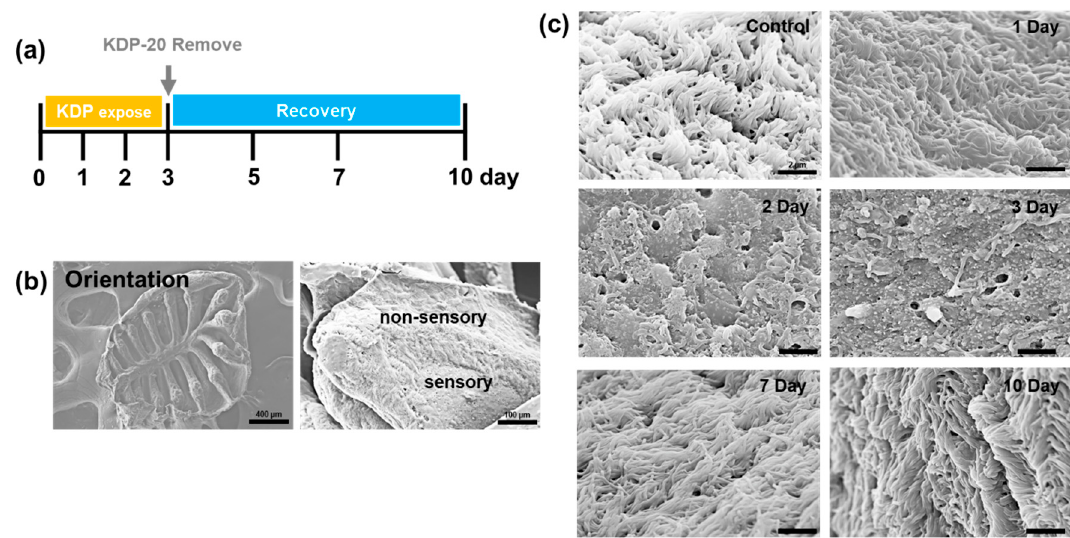
Figure 3. ( a ) Scheme of KDP20 exposure experiment. ( b ) Orientation of olfactory organs. Olfactory organ has rosette-like shape and contains non-sensory and sensory area. To analyze the damage of KDP20 exposure to olfactory sensory neurons (OSNs), we observed cilia and the epithelium of the sensory area. Scale bar = 100 µm. ( c ) Field emission scanning electron microscope (FE-SEM) images of cilia in the sensory area of control, damage group (1, 2, and 3 days), and recovery group (7 and 10 days). Scale bar = 2 µm.